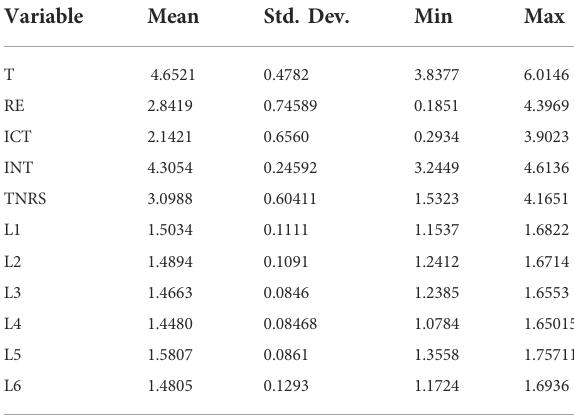
TABLE 5 Summary statistics (developed E.U.